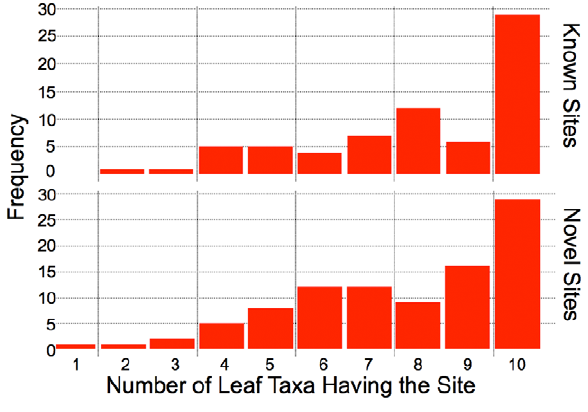
Figure 5. Histogram of number of extant Drosophilids predicted to share a given site, for known sites (top pane) and novel predicted sites (bottom pane), over a 10-way phylogeny.